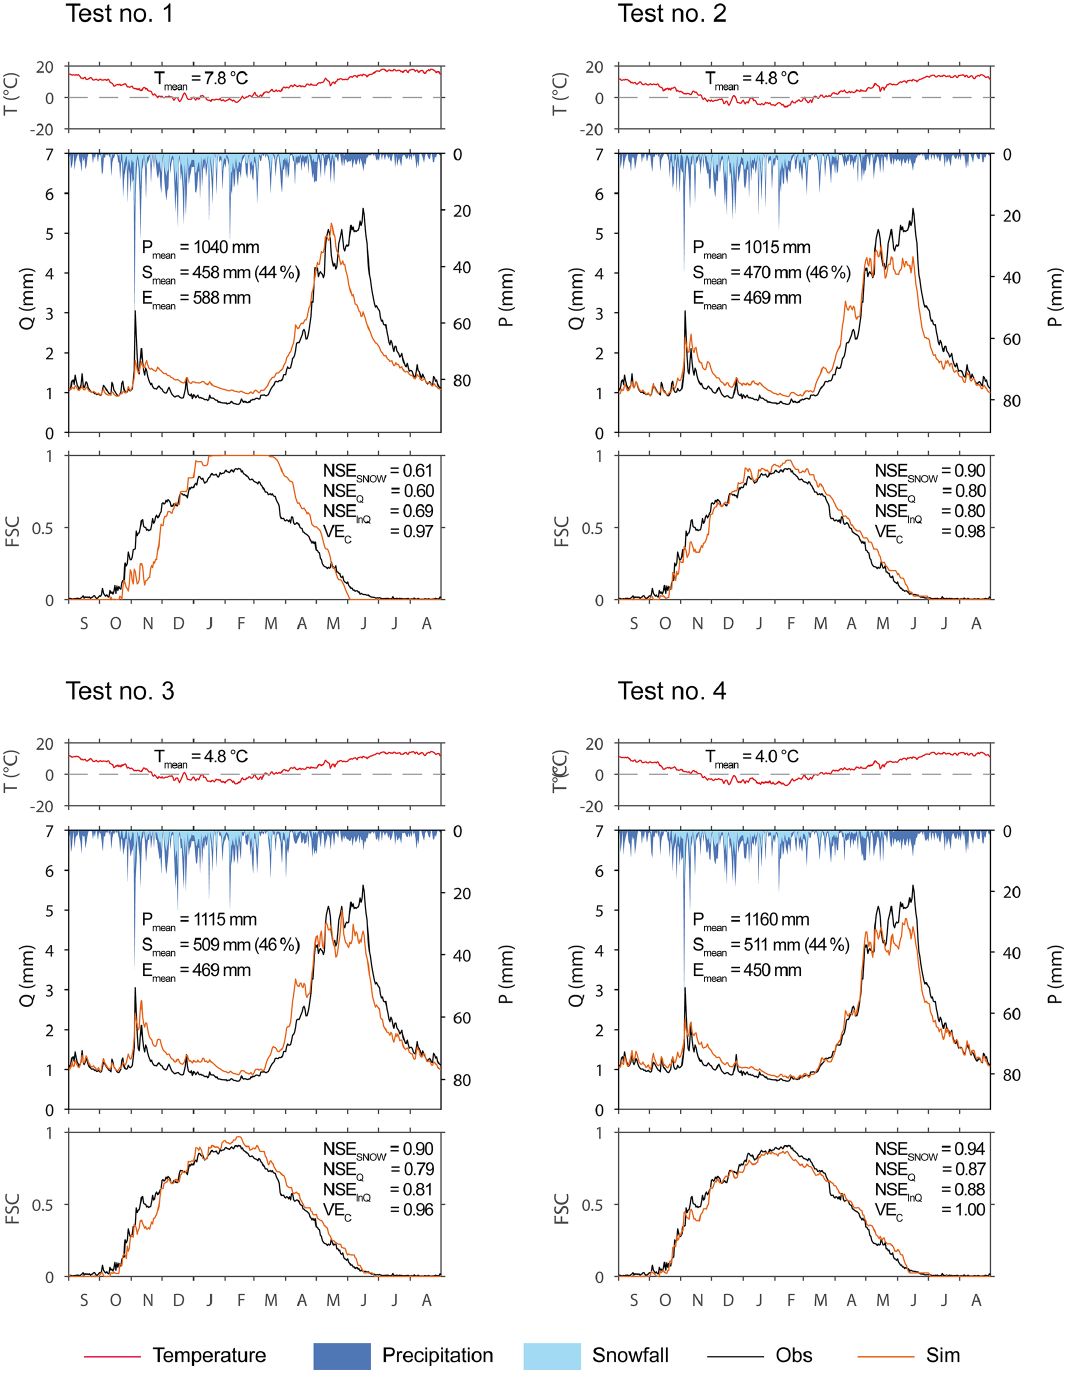
Figure 7. Comparison of snow-hydrological simulations with elevation dependency according to Test nos. 1 to 4 (see Table 5) with GR4J for the Durance at Serre-Ponçon. The graphs show mean inter-annual time series of temperature, precipitation, streamflow, and fractional snow cover at the catchment scale in validation over the period 2008–2016. T mean , P mean , and S mean stand for mean annual temperature, precipitation, and snowfall, respectively. The efficiency criteria NSE SNOW , NSE Q , NSE ln Q , and VE C are computed from continuous (not mean seasonal) series over